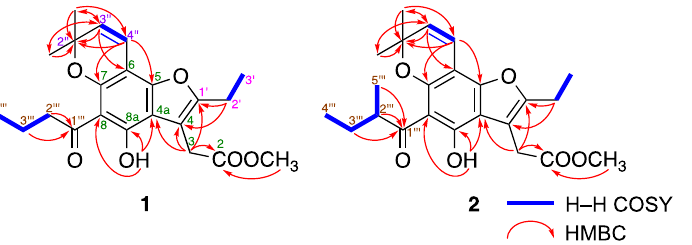
Figure 2. 1 H– 1 H COSY and HMBC correlations of 1 and 2 .